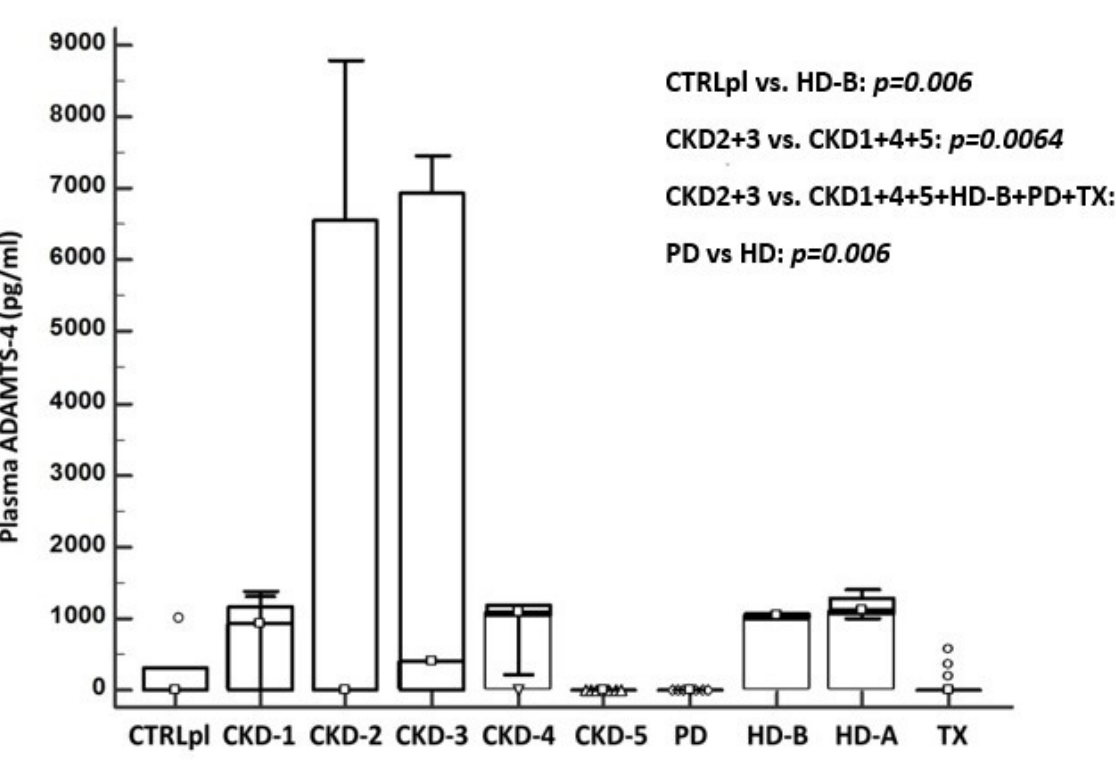
Figure 5. Concentration of ADAMTS-4 protein detected in plasma of healthy subjects in control group (CTRLpl), chronic kidney disease (CKD stages 1–5), on peritoneal dialysis (PD), hemodialysis (before HD-B and after HD-A), and kidney transplant patients (TX). The box plot displays the lower to upper quartile (25th to 75th percentiles) and median (middle line); the minimum and maximum levels as horizontal lines outside the box; and far-out values are plotted with a different marker ( ◦ ). Significant difference of mean ADAMTS-4 plasma concentrations was found between CTRLpl and HD-B group ( p = 0.006) and also varied significantly between CKD stages being highest in patients with CKD stages 2 and 3 compared to CKD 1 + 4 + 5 ( p = 0.0064) and CKD 1 + 4 + 5 + HD-B + PD + TX ( p = 0.00004). None of the patients in PD group had detectable plasma ADAMTS-4, which differed significantly from the HD group ( p < 0.00001).